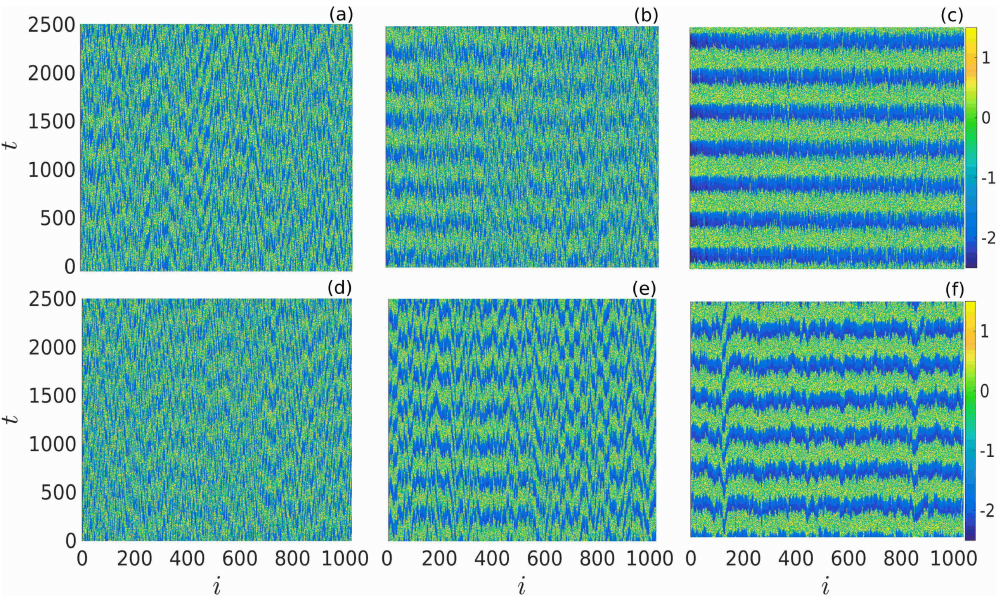
Figure 4. Spatial–temporal pattern of the membrane potential represented by the fast variable x for the scale-free network in panel ( a ) ( ε = 0.002), panel ( b ) ( ε = 0.005), and panel ( c ) ( ε = 0.040) and for the small-world network in panel ( d ) ( ε = 0.002), panel ( e ) ( ε = 0.011), and panel ( f ) ( ε = 0.040). In the phase synchronized states, horizontal lines, which are related to the bursting synchronization, are